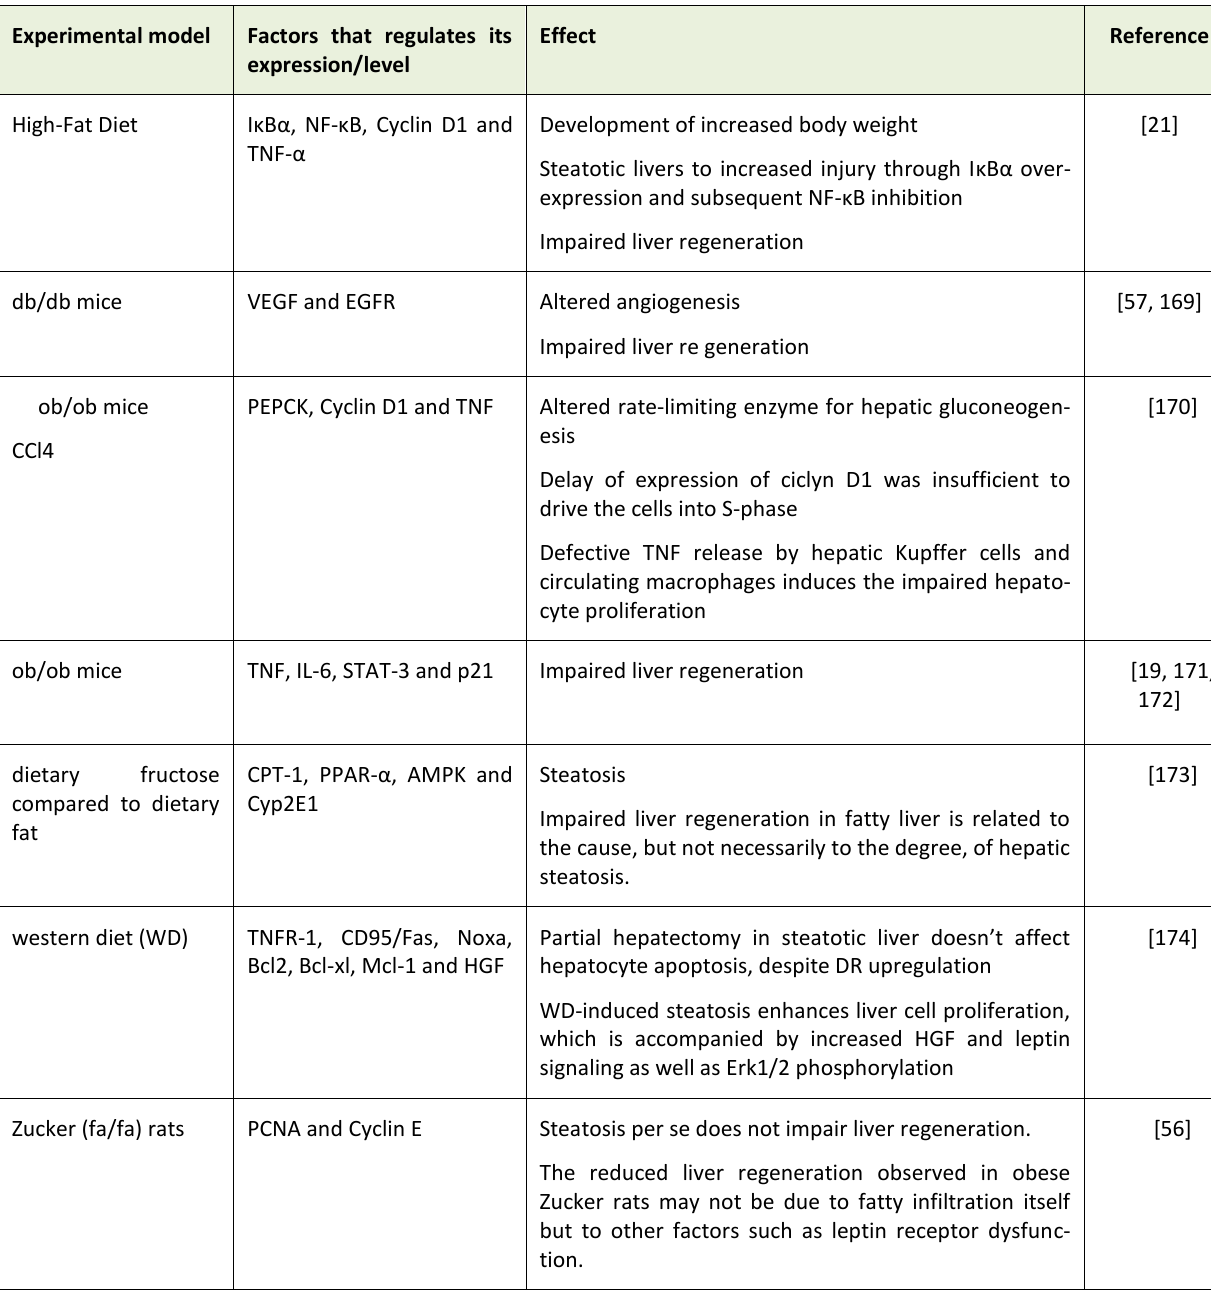
TABLE 1. Summary of effects of Non-alcoholic fatty liver disease (NAFLD) in various models on liver regeneration. Experimental